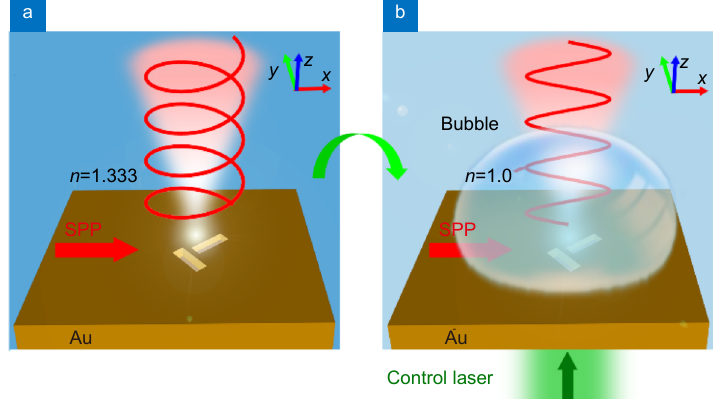
Fig. 1 | ( a ) Circularly polarized emission light as the plasmonic emitter is covered by water ( n =1.333). ( b ) Linearly polarized emission light as the plasmonic emitter is covered by a bubble ( n =1.0) induced with a control laser